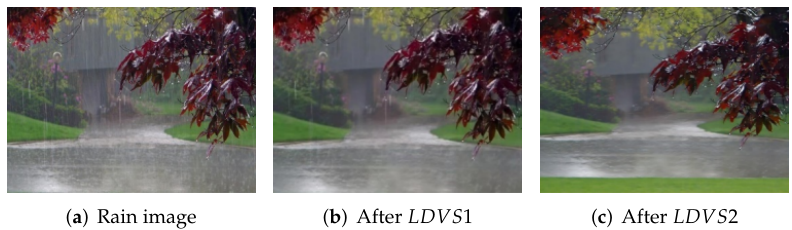
Figure 18. Test results of LDVS on real images from Real Data . The first column is the original real rainy image, the second is after LDVS 1, and the third is after LDVS